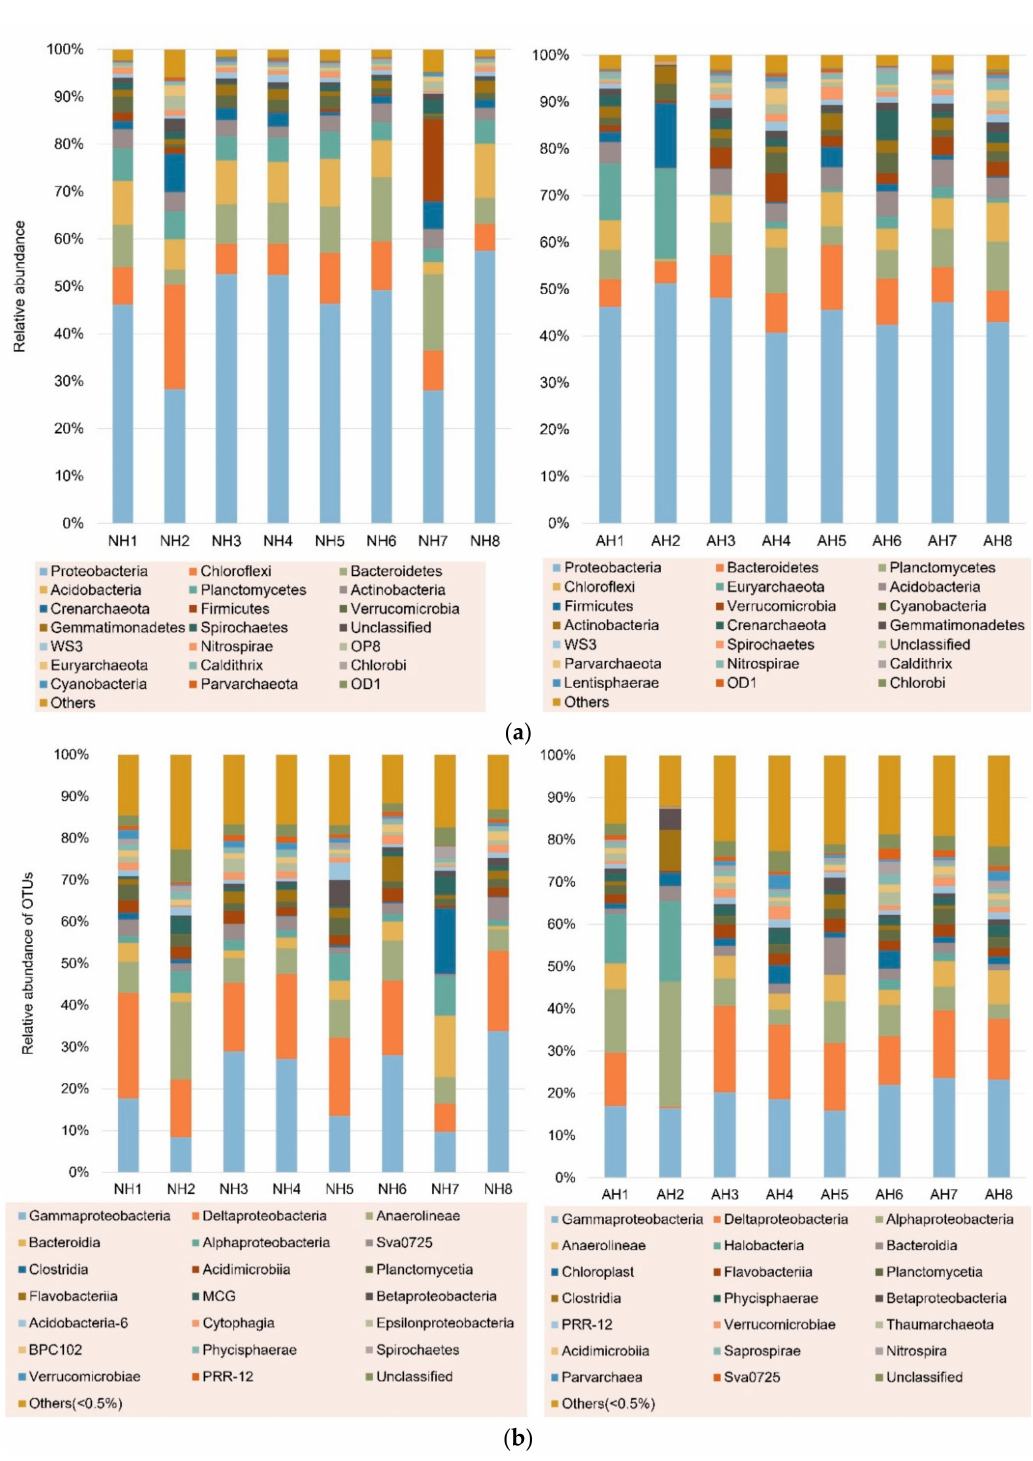
Figure 2. Taxonomic composition distribution histograms in each sample at ( a ) phylum and ( b ) class